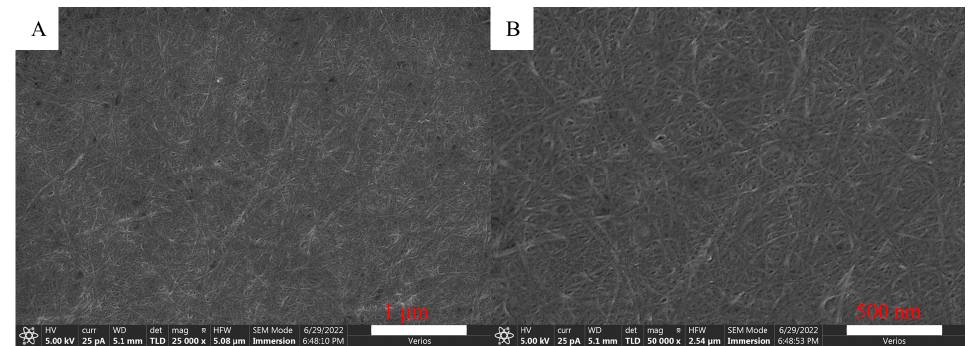
Figure 2. SEM images of CNF (( A ) Low magnification; ( B ) High magnification). The TG curves of cellulose and CNF from durian rinds are shown in Figure 3. The TG curve of CNF was quite similar to cellulose. Both of them had only one pyrolysis temperature at about 330 ◦ C. It indicated that the products had high purity and stable thermal properties.